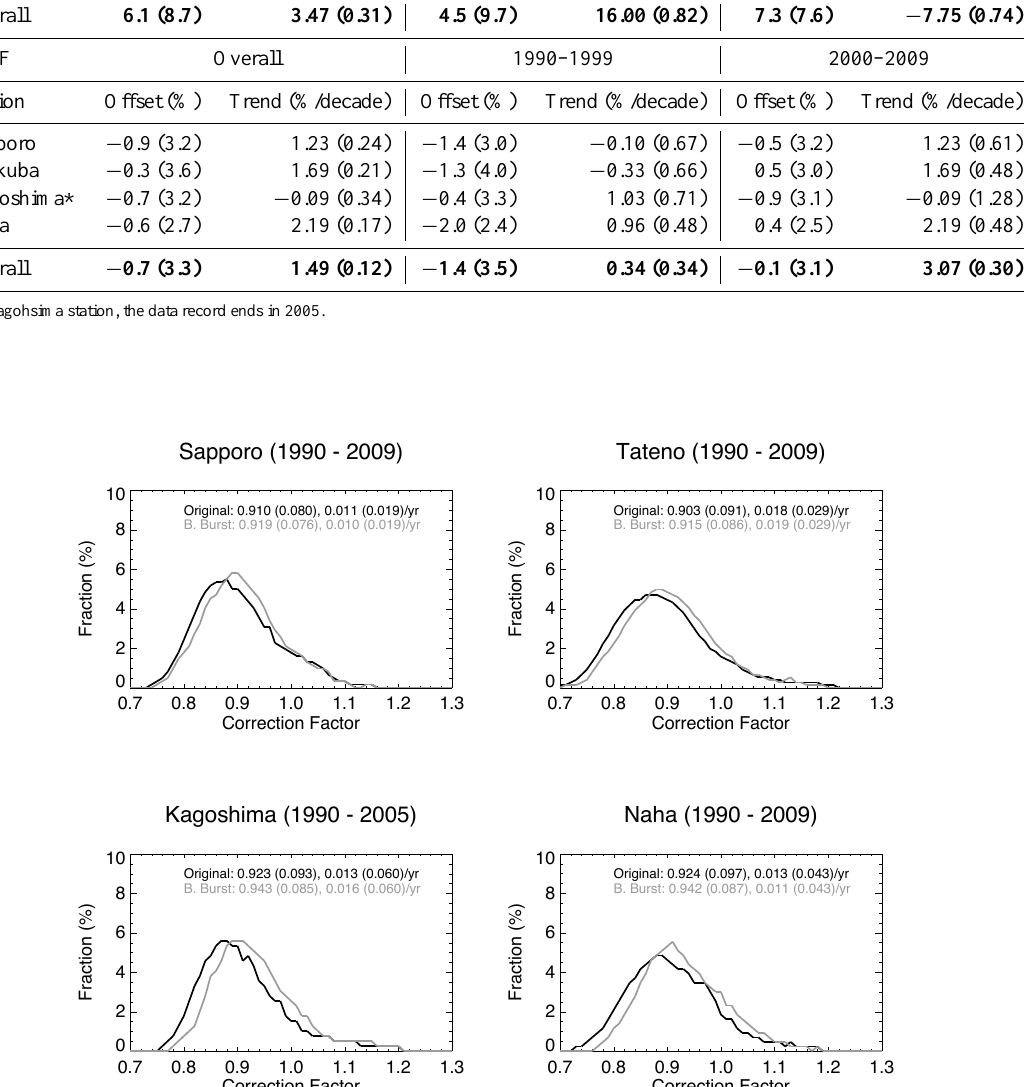
Fig. 2. Histograms showing a comparison of the corrections factors applied and listed in the WOUDC data files with those calculated in this study using a balloon-burst climatology. For all stations, the balloon-burst correction factors are nearer to 1.0. The numbers in parenthesis represent one standard deviations.